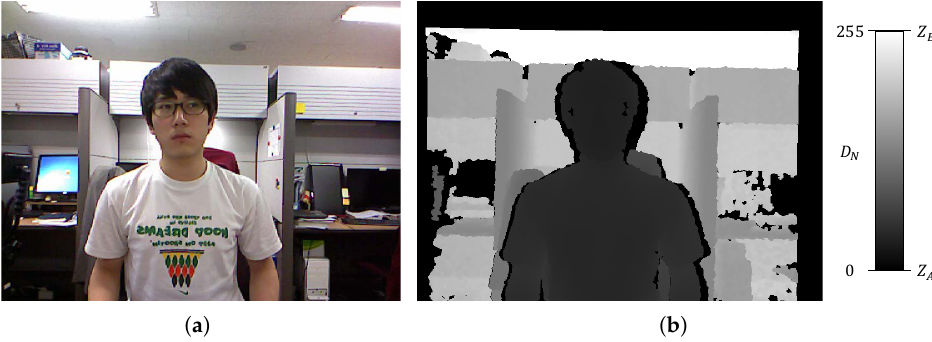
Figure 3. Aligned ( a ) color and ( b ) depth image pair. The depth images are normalized to D N (between 0 and